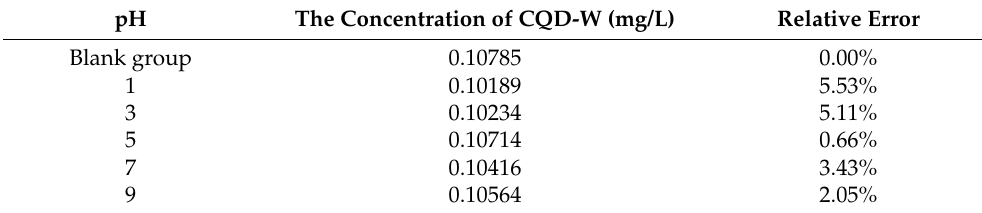
Table 3. Effect of pH on concentration test of CQD-W.